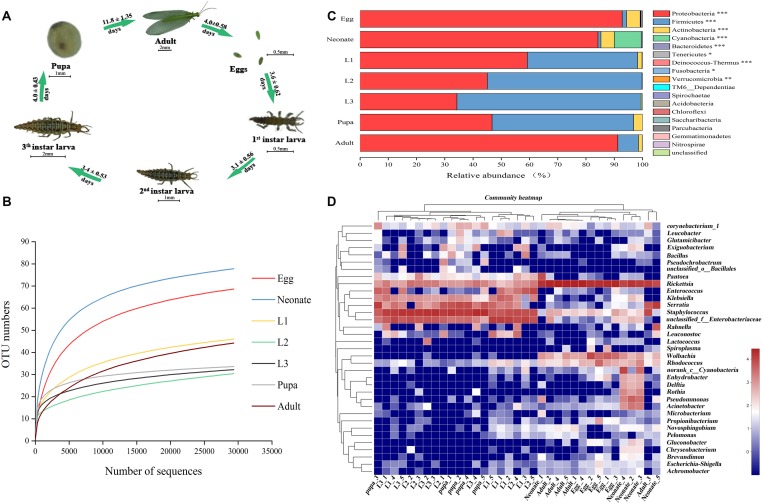
Bacterial community dynamics among different developmental stages in Chrysoperla sinica.
(A) Overview of development stages of the C. sinica. (B) Rarefaction curves constructed from randomly subsampled data sets with the same number of 16S sequences. The near-saturated rarefaction curve indicates that the vastness of microbial diversity was captured from each sample. (C) Relative abundance of bacteria communities at the phylum level in different groups (Non-parametric Kruskal–Wallis test ∗0.01 < P ≤ 0.05, ∗∗0.001 < P ≤ 0.01, and ∗∗∗P ≤ 0.001). (D) Heat map of major taxa over the life cycle at the genus level. Cluster analysis using the Bray–Curtis distance and the complete-linkage method. Each column represents a single replicate of each of the seven treatments. Columns were clustered according to the similarity of bacterial abundance profiles. Each row represents an OTU assigned to the genus level. Color gradient represents the proportion of species. Plotting scale, from red to blue, indicates the decrease in richness of bacterial communities. Five replicates are labeled 1–5.